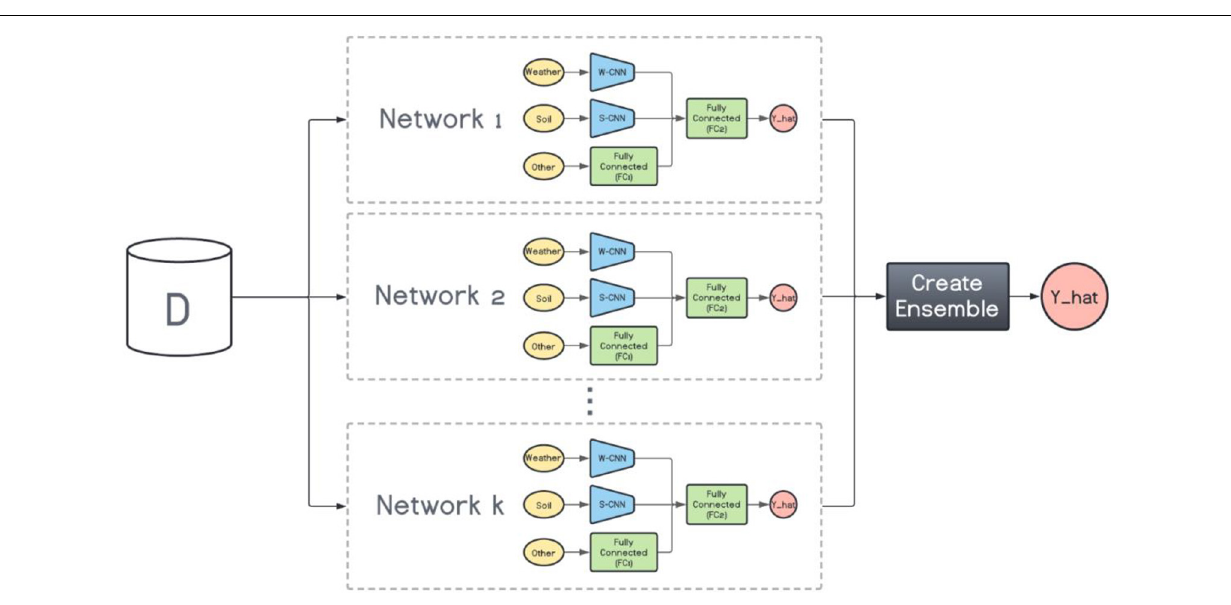
FIGURE 3 | Heterogenous ensemble creation. k networks with the same architecture but with different hyperparameters are created using the original data set